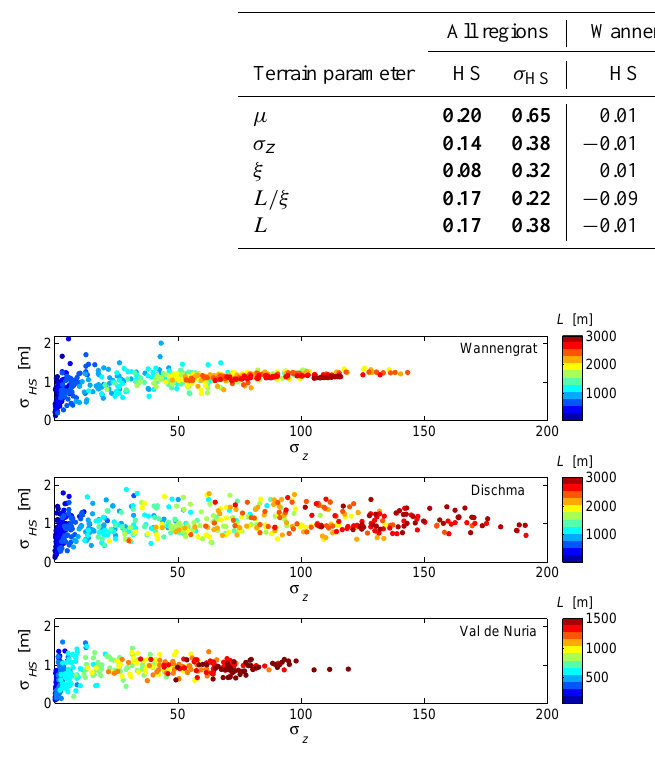
Figure 6. Standard deviation of snow depth σ HS as a function of detrended valley-to-peak elevation difference σ (indicated by σ z ) of the underlying topographic features. Colors indicate corresponding domain size L .